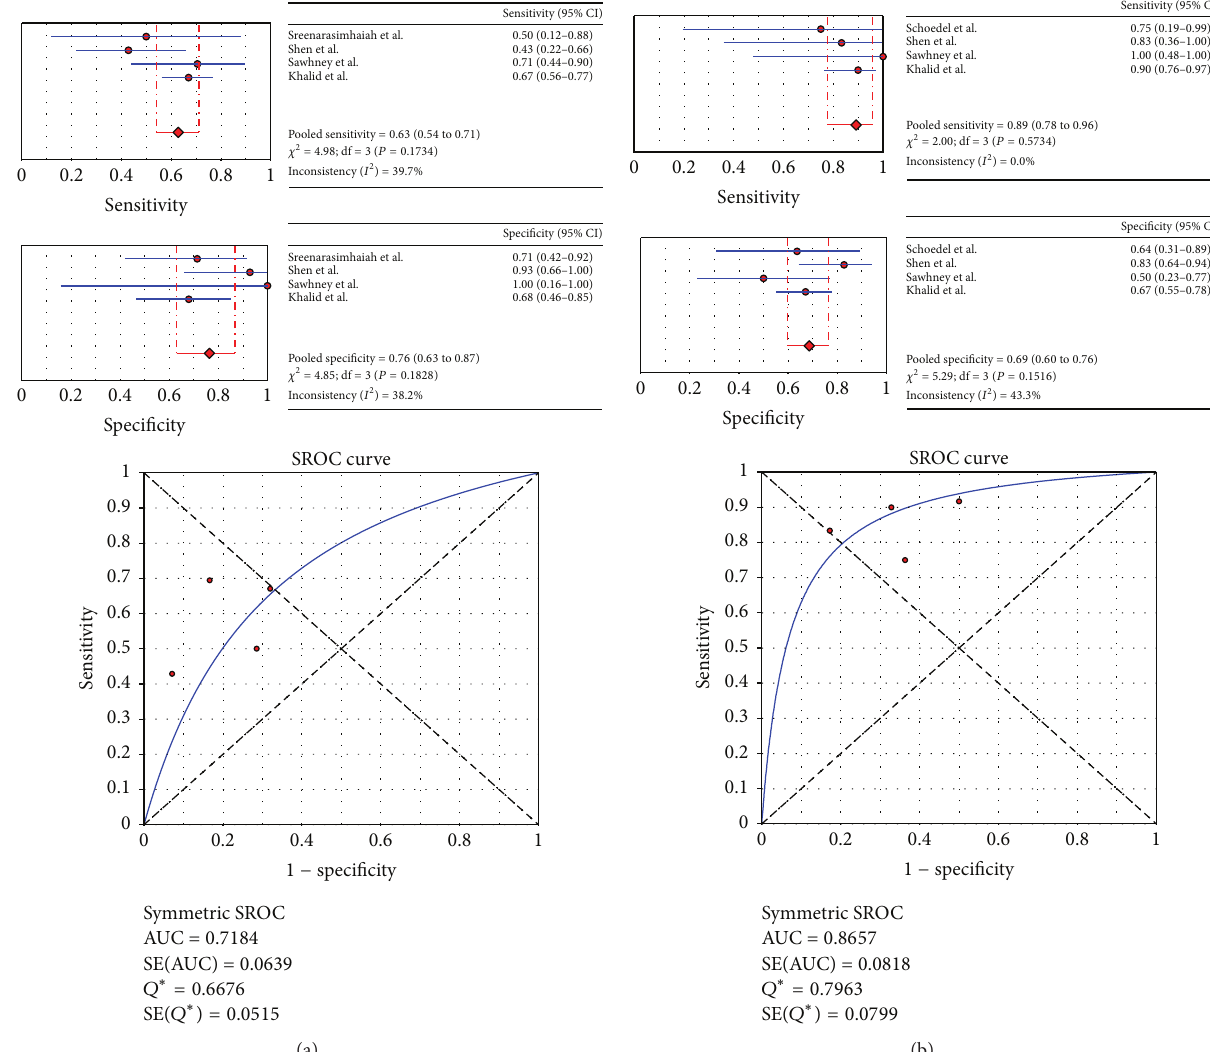
Figure 3: Forest plots of estimates of sensitivity and specificity and SROC in studies of LOH for the diagnosis of mucinous (a) and malignant (b) cysts.